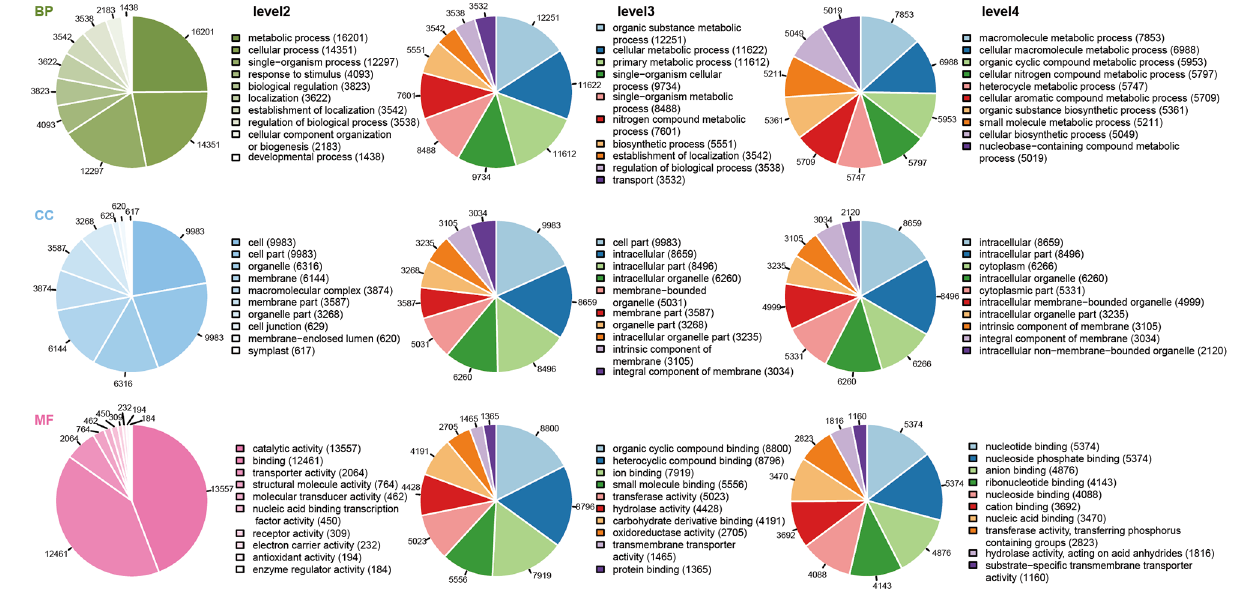
Fig 3. GO term level 2,3 categories of unigenes of C . officinalis .